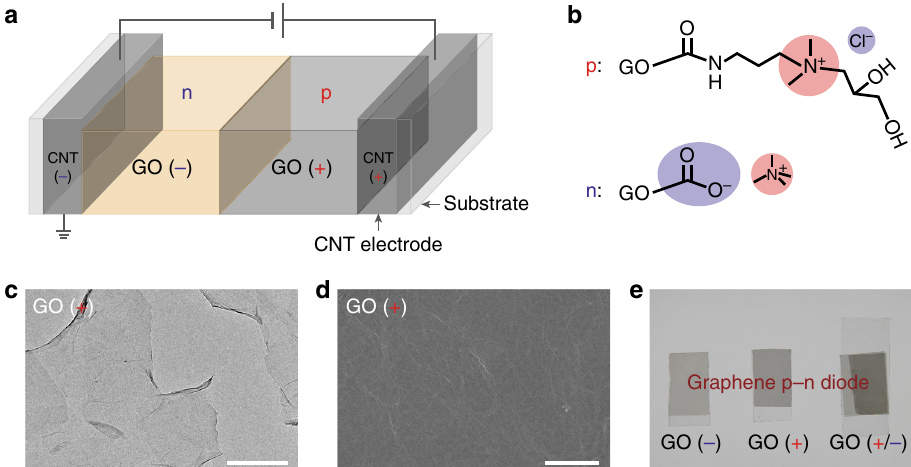
Fig. 1 Fabrication of an all carbon materials pn diode. a The scheme of an all carbon materials pn diode consisting of a 40 nm-thick negatively charged GO ( − ) layer (n), a 40 nm-thick positively charged GO( + ) layer (p), two 20 nm-thick CNT conducive electrodes, and two transparent glass supports. b The molecular structures of chemically functionalized positively (p) and negatively (n) charged graphene oxides. The mobile counterions are chloride anion and tetramethyl ammonium cations, respectively. c The typical TEM image of highly dispersed positively charged GO sheets. Scale bar, 500 nm. d The surface morphology (SEM image) of a 40 nm-thick positively charged GO( + ) layer with a 20 nm-thick CNT layer at the bottom. Scale bar, 2 μ m. e The photographs of negatively charged GO layer (left, 40 nm-thick), positively charged GO layer (middle, 40 nm-thick), and laminated layers (right). (Note: both positively and negatively charged GO have conductive CNT electrodes (20 nm-thick) at the